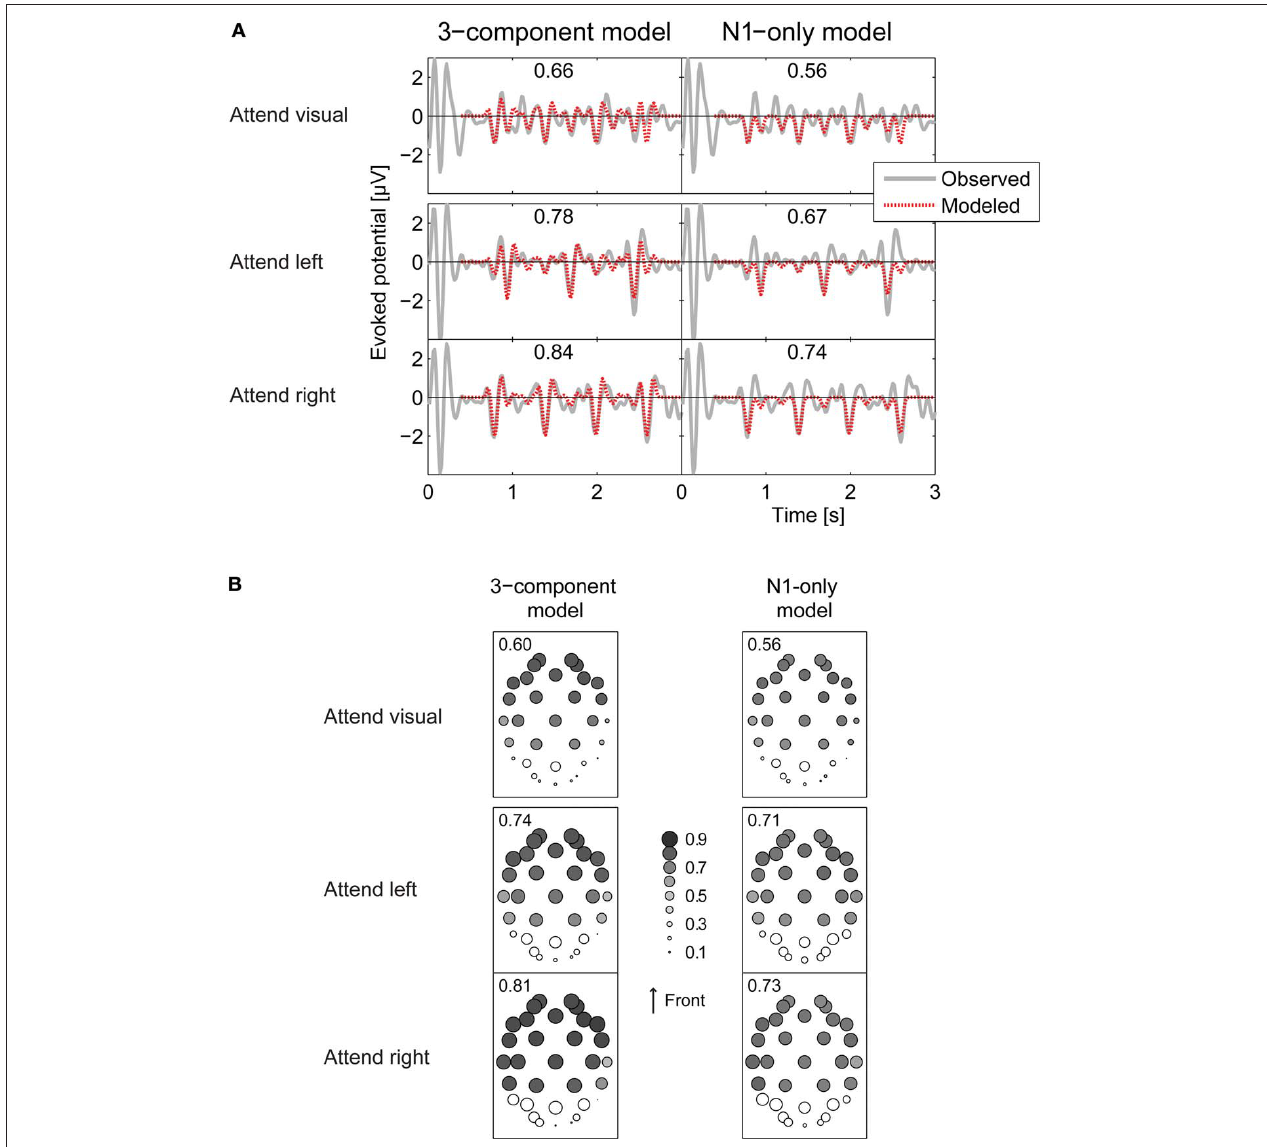
FIGURE 7 | Comparing observed and modeled ERPs. (A) Observed (gray solid curve) and modeled (red dashed) ERP waveforms at the Fz electrode. Numbers in parentheses give the correlations coefficient between the observed and modeled ERPs. Top panels: attend-visual condition; middle panels: attend-left condition; bottom panels: attend-right condition. Left panels show the 3-component model fits; right panels show the N1-only model fits. Overall fits are better for the 3-component model than the N1-only